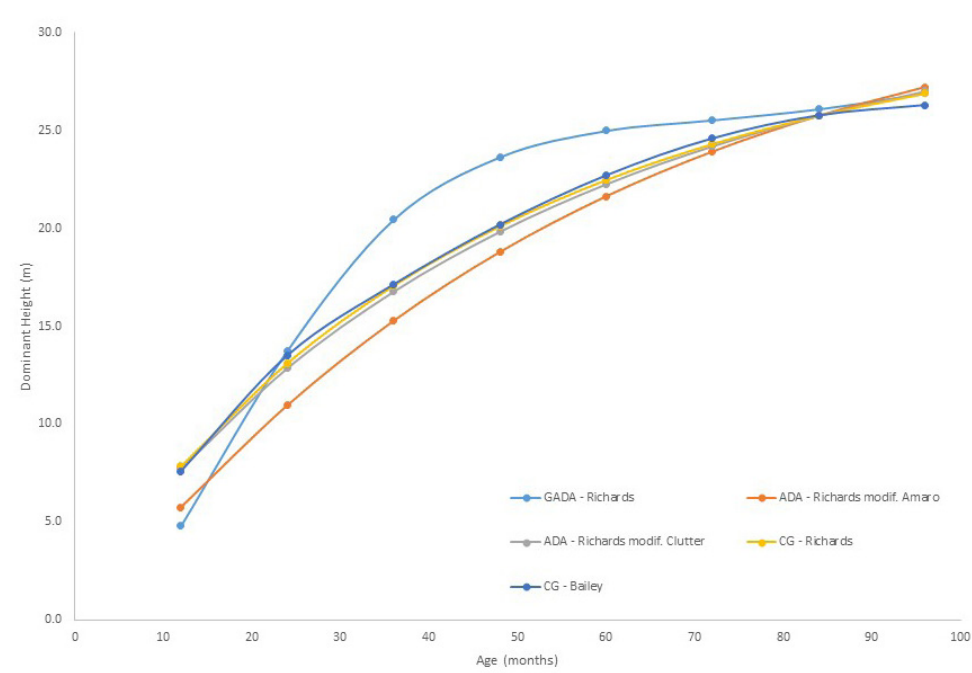
Figure 3. Growth curves of the five fitted models for stands of Eucalyptus sp. in a tropical region of